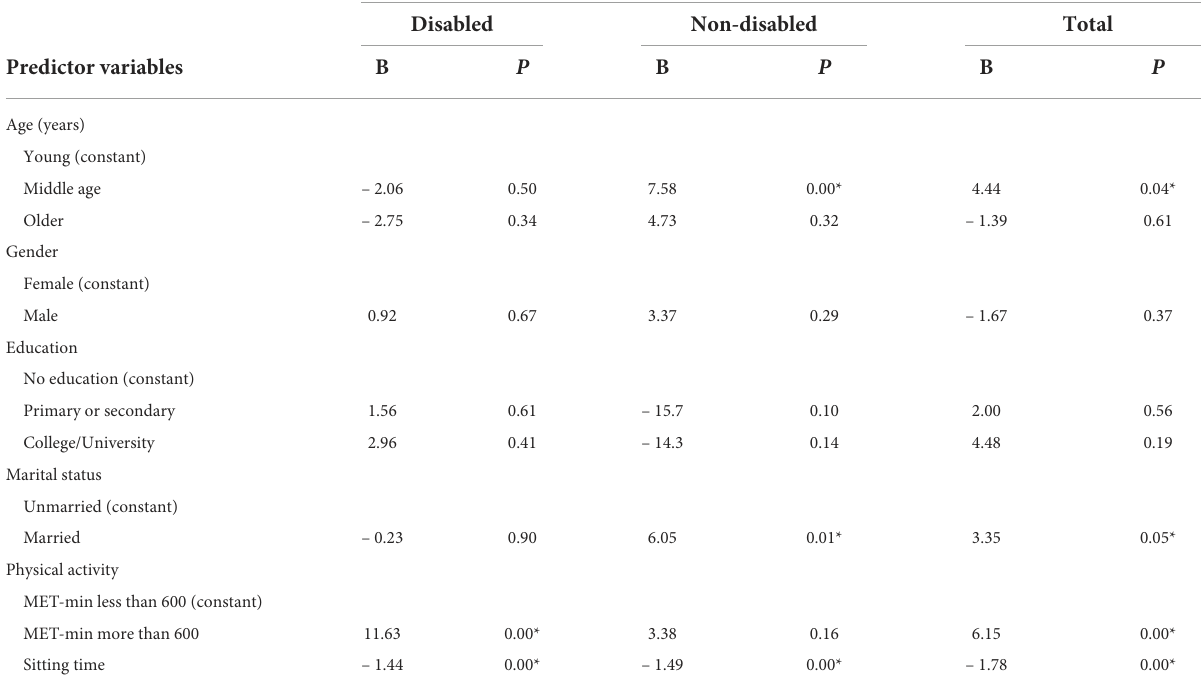
TABLE 4 Associations of demographic variables, physical activity level and sitting time with Psychological QOL (Linear Regression